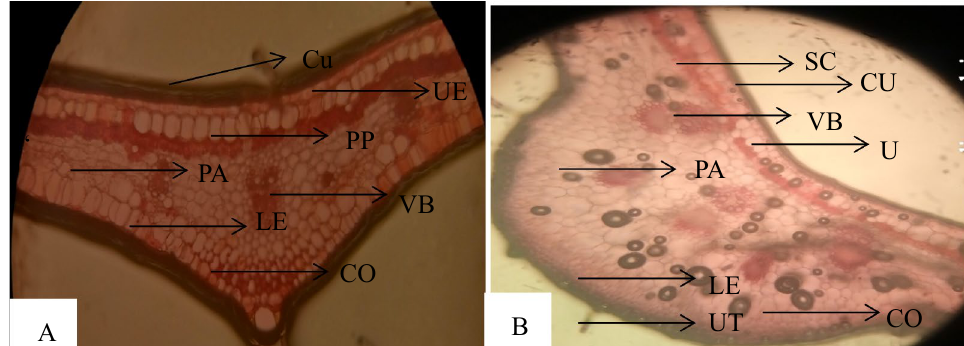
Fig. 5 Transverse sections of Petioles 100; A Costus afer B Palisota hirsuta . CO: collenchyma; CU: Cuticle; LE: lower epidermis, PA: parenchyma; PP: × palisade parchyma; UE: upper epidermis; UT: unicellular non-glandular trichome; VB: vascular bundle. Briefly, scalpel was used to cut a tiny strip of the plants through the petiole. The transverse sections obtained were cleared using 2% v/v sodium hypochlorite, washed severally in water, stained with Safranin O, dehydrated in 50%, 70% and 100% Ethanol, mounted in dilute, glycerol, viewed under microscope and, photomicrograph was taken with the aid of phone